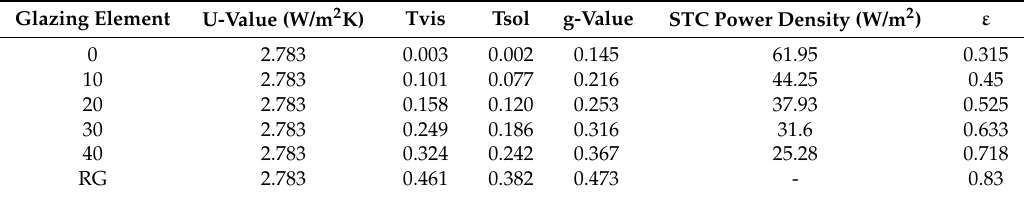
Table 6. Thermal and optical proprieties of the glazing elements used for validation. Glazing